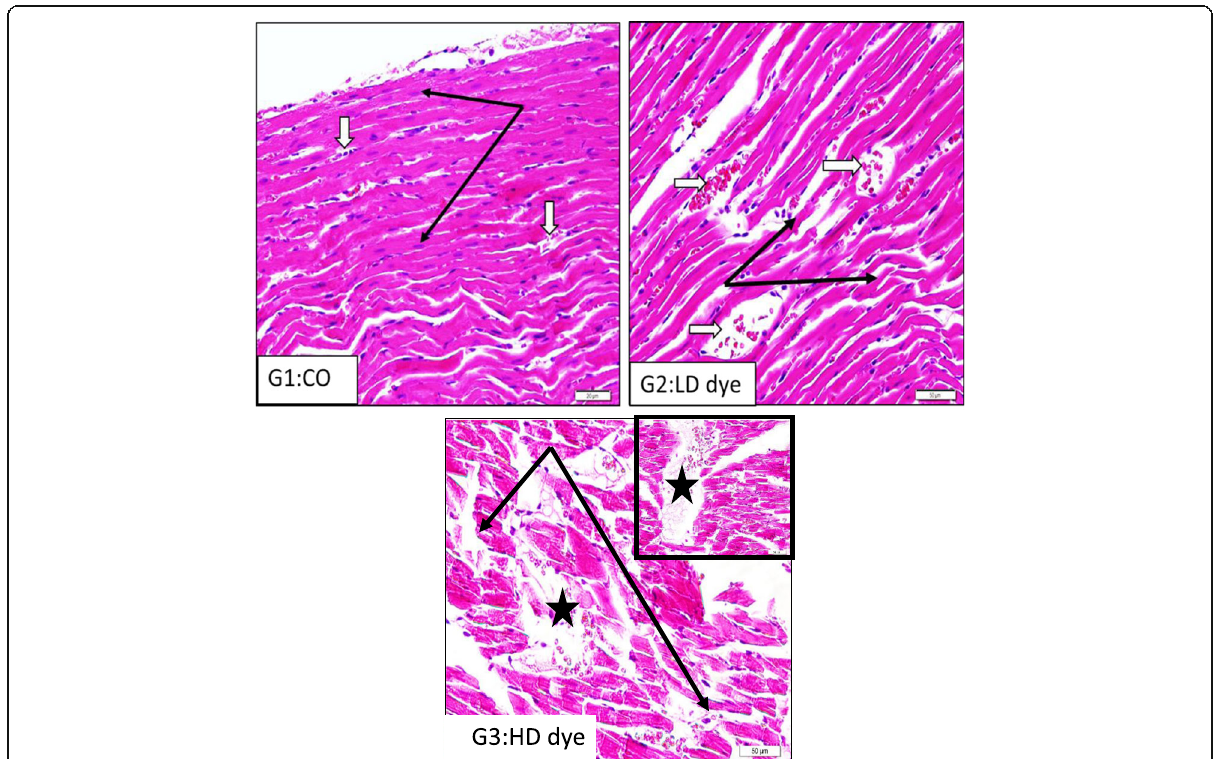
Fig. 1 Sections in the rat cardiac muscle (left ventricle) show the following: G1: Co (control) with normal cardiac muscle fibers having oval central nuclei (black arrows) and thin wall intervening capillaries (white arrows) (H-E, ×200). G2: LD dye (low dose) showing focal atrophy with mononuclear inflammatory cells (black arrows) and numerous dilated and congested vessels (white arrows) (H-E, ×200). G3: HD dye (high-dose dye) showing marked disorganization and damage of cardiac fibers (arrows) with focal regions of severe necrosis fiber loss (stars) (H-E, ×200)